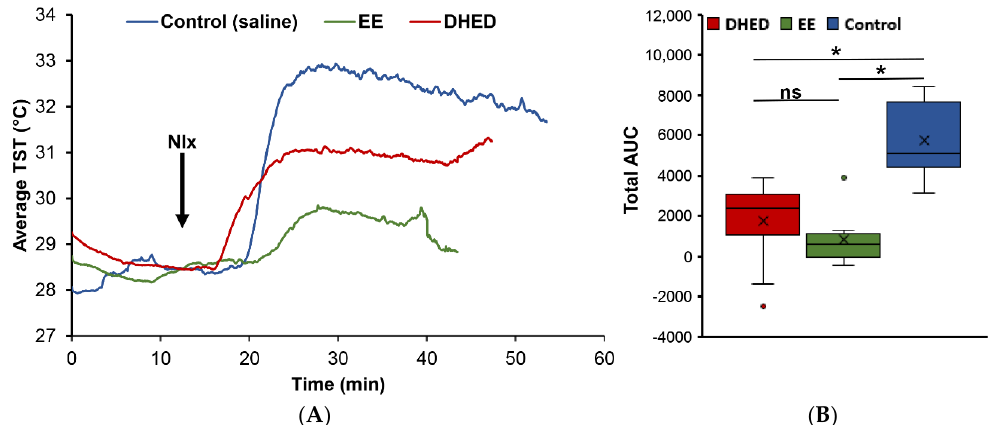
Figure 3. ( A ) Representation of tail skin temperature (TST) changes over time in ORDX animals receiving vehicle (blue), ethinylestradiol (EE; green, 1 mg/kg/day body weight, p.o., twice daily (b.i.d.) for 13 days) and DHED (red, 300 µg/kg/day body weight, p.o., b.i.d. for 13 days) treatments after naloxone (Nlx) challenge. TST rose and reached peak values 10–15 min after treatment with the opioid antagonist, then decreased slowly and returned to baseline (not shown) within an hour and a half. ( B ) Boxplots comparing area under the curve (AUC) distributions by treatment groups specified in panel ( A ). The overall analysis of variance (ANOVA) indicated a statistically significant difference in mean AUC among the three groups. Post hoc Tukey’s multiple comparison tests showed that the mean AUC in the control group was significantly different from the AUCs of the DHED and EE groups (* p < 0.05), which were not significantly different (ns) from each other.